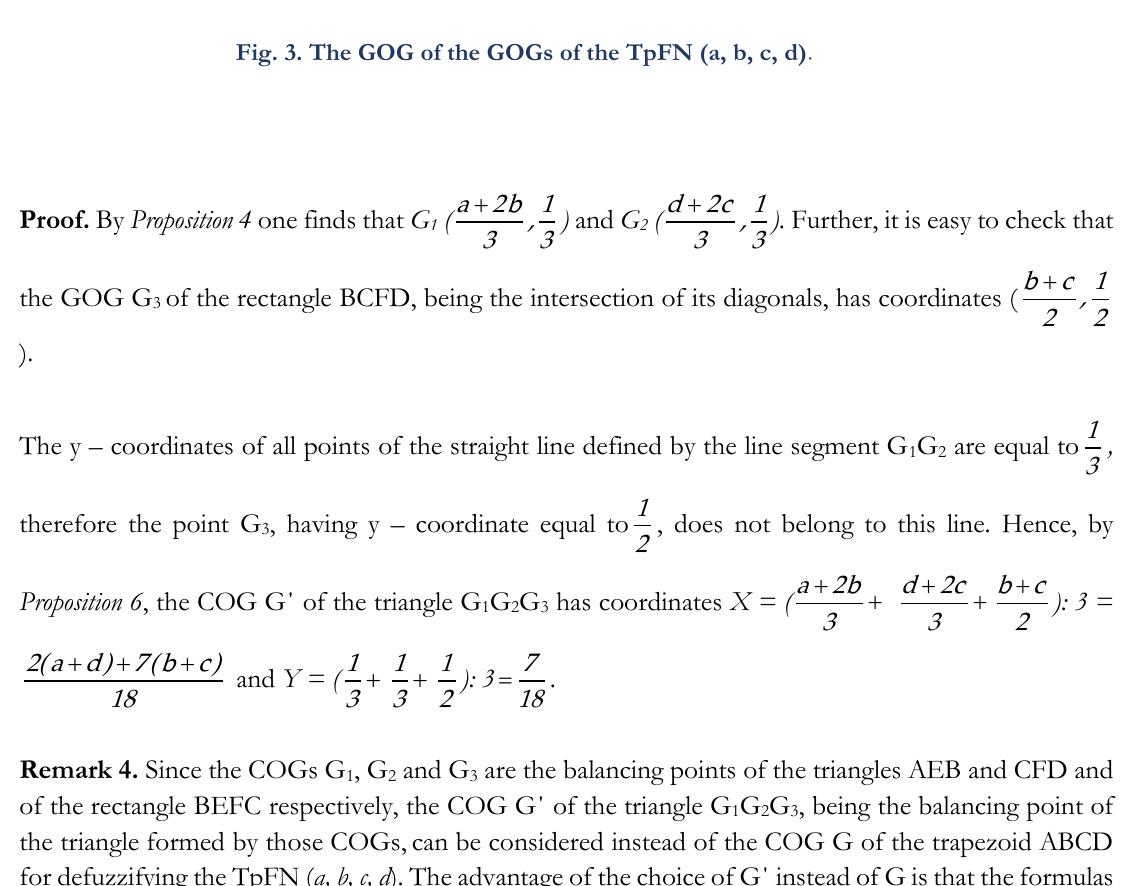
Fig. 3. The GOG of the GOGs of the TpFN (a, b, c, d)